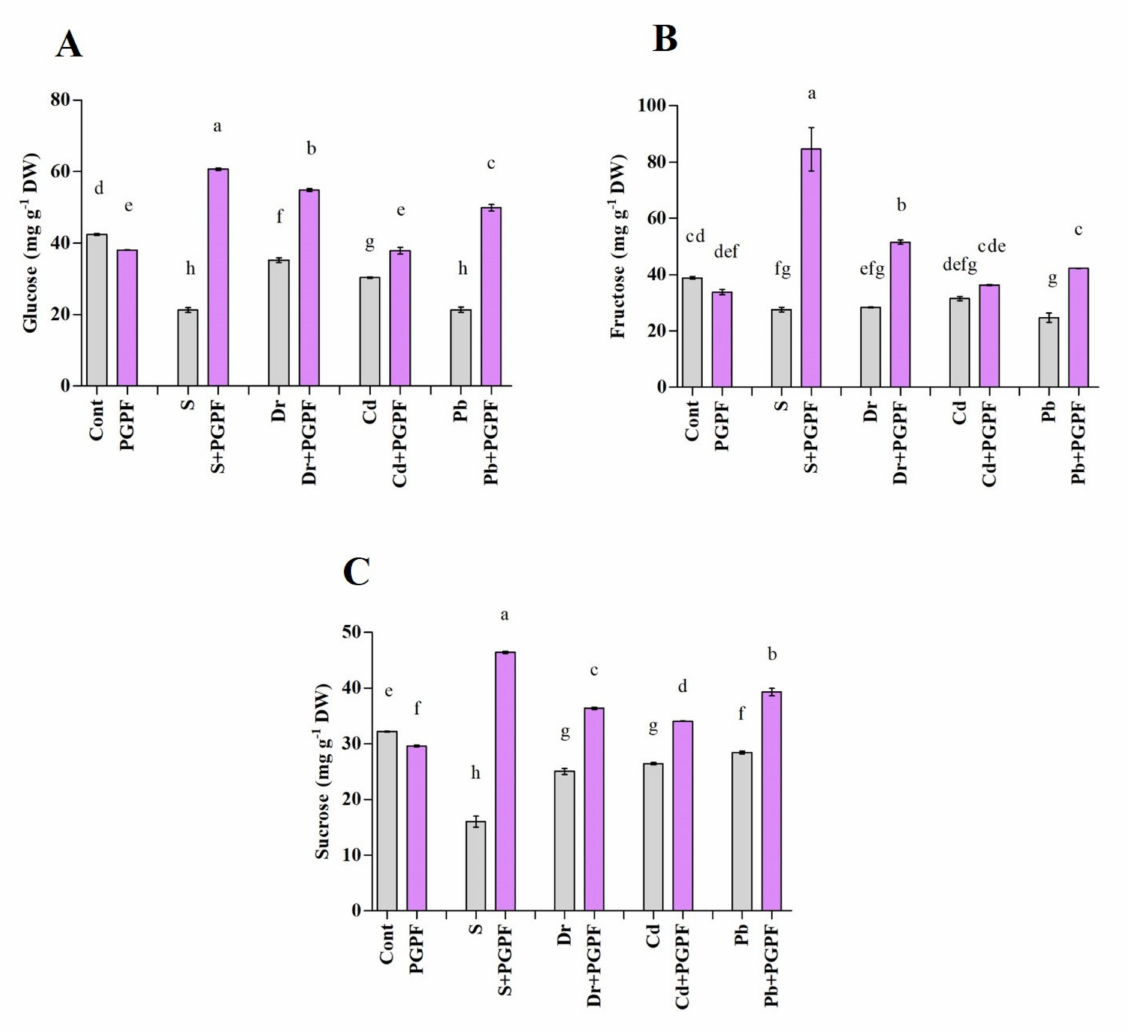
Figure 8. ( A ) Glucose, ( B ) Fructose, and ( C ) Sucrose contents in leaves of tomato plants grown under normal and stress conditions and inoculated with PGPF for 10 days. Treatments: Cont (control), PGPF ( Cunninghamella bertholletiae ), S (1.5% sodium chloride), S (1.5% sodium chloride) + PGPF ( Cunninghamella bertholletiae ), Dr (25% polyethylene glycol), Dr (25% polyethylene glycol) + PGPF ( Cunninghamella bertholletiae ), Cd (3 mM cadmium), Cd (3 mM cadmium) + PGPF ( Cunninghamella bertholletiae ), Pb (3 mM lead), and Pb (3 mM lead) + PGPF ( Cunninghamella bertholletiae ). Values are shown as the means ± SD ( n = 5) and significant differences at p < 0.05 (Tukey test) are indicated by different lowercase letters above the